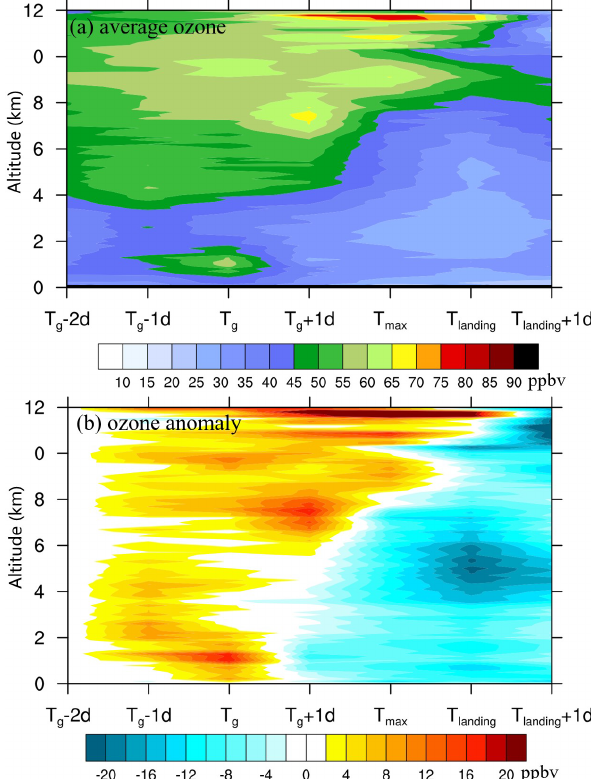
Figure 5. (a) Vertical ozone concentrations (in ppbv) at each ty- phoon developmental stage averaged over the typhoon ensemble for 2014–2018 in Taiwan. (b) Anomalies in the vertical ozone concen- trations relative to the T g − 2d stage for the subsequent typhoon de- velopmental stages. The temporally dense ozone profiles are avail- able from airborne observations of the atmospheric composition collected at Taoyuan International Airport in Taiwan within the framework of the IAGOS